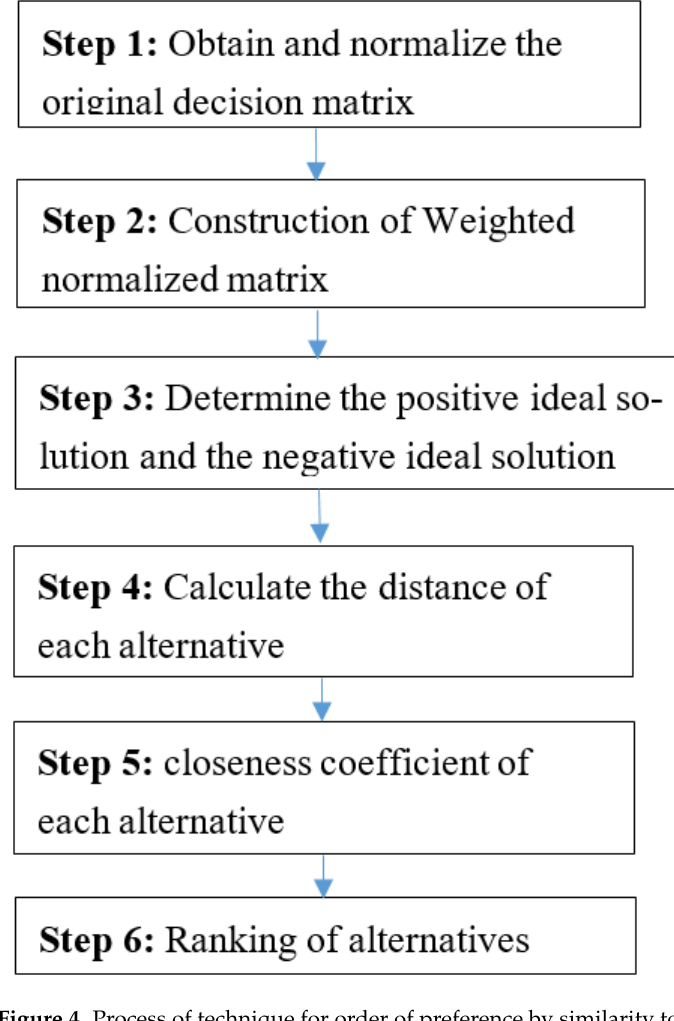
Figure 4. Process of technique for order of preference by similarity to ideal solution (TOPSIS).